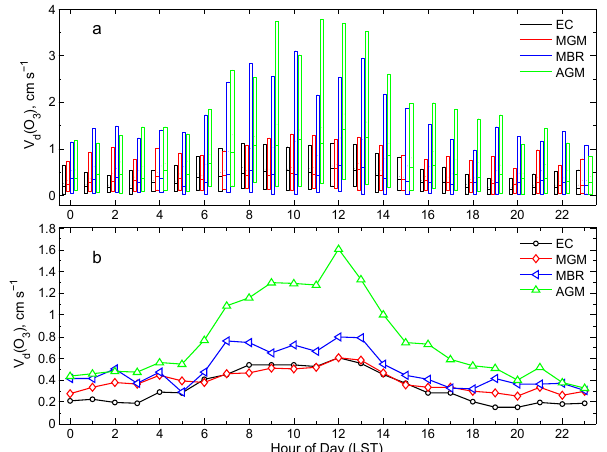
Figure 4. (a) The box plot of hourly V d ( O 3 ) and (b) diurnal average cycles of V d ( O 3 ) at Harvard Forest during 1993–2000 as measured by the eddy covariance (EC) and three gradient methods (MGM: the modified gradient method; MBR: the modified Bowen ratio method; AGM: the aerodynamic gradient method). In each box, the central mark is the median, and the edges of the box are the 10th and 90th percentiles. Note that the average is the arithmetic mean of the data between the 10th and 90th